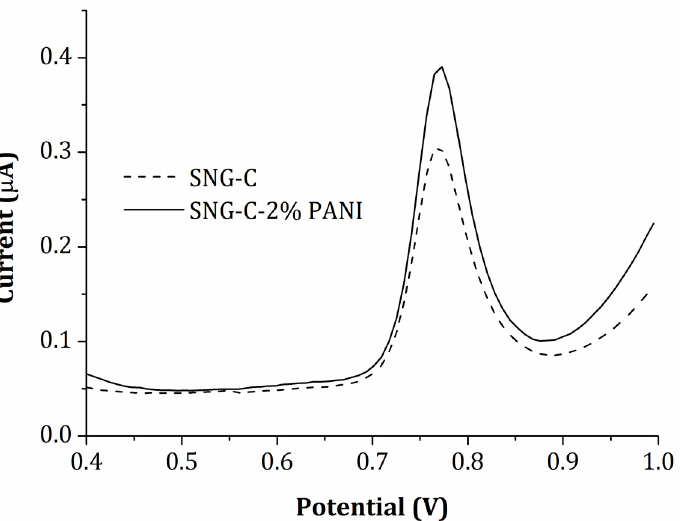
Figure 3. Differential pulse voltammograms recorded with SNG–C–2% PANI and SNG–C in presence of 10 µ M of PCMC in 0.1 M acetic/acetate buffer (ABS) at pH 4 with 0.5 M KCl.